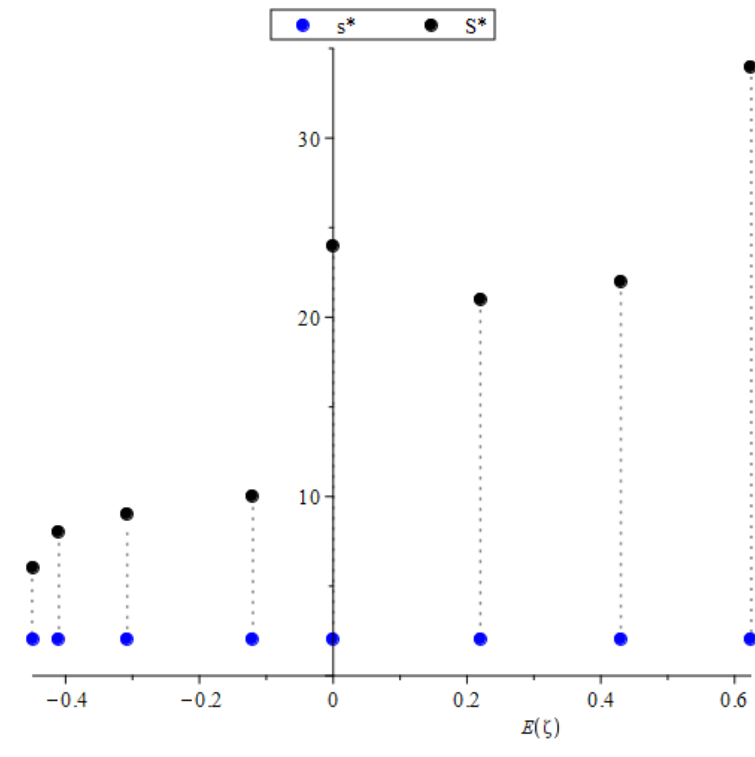
Figure 5. ( S ∗ , s ∗ ) corresponding to E ( ξ ) , Scenario 1.